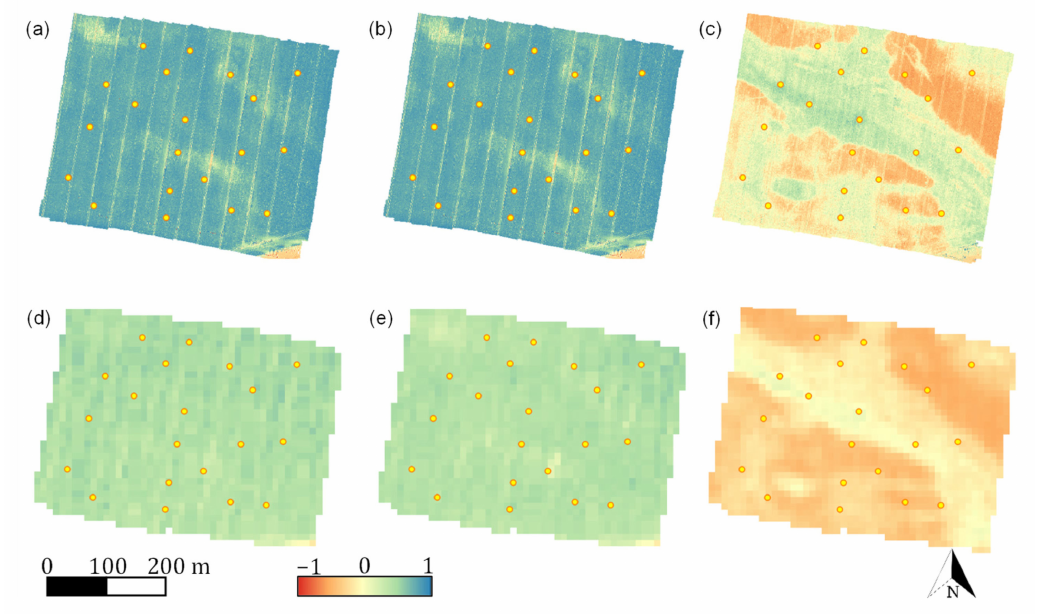
Figure 7. Modified green red vegetation index (MGRVI) of the study area G for barley. UAV imagery was acquired on ( a ) 16 April 2019, ( b ) 13 May 2019, and ( c ) 13 June 2019. Sentinel-2 imagery was acquired: on ( d ) 9 April 2019, ( e ) 12 May 2019, and ( f ) 13 June 2019. The points indicate the locations for reference